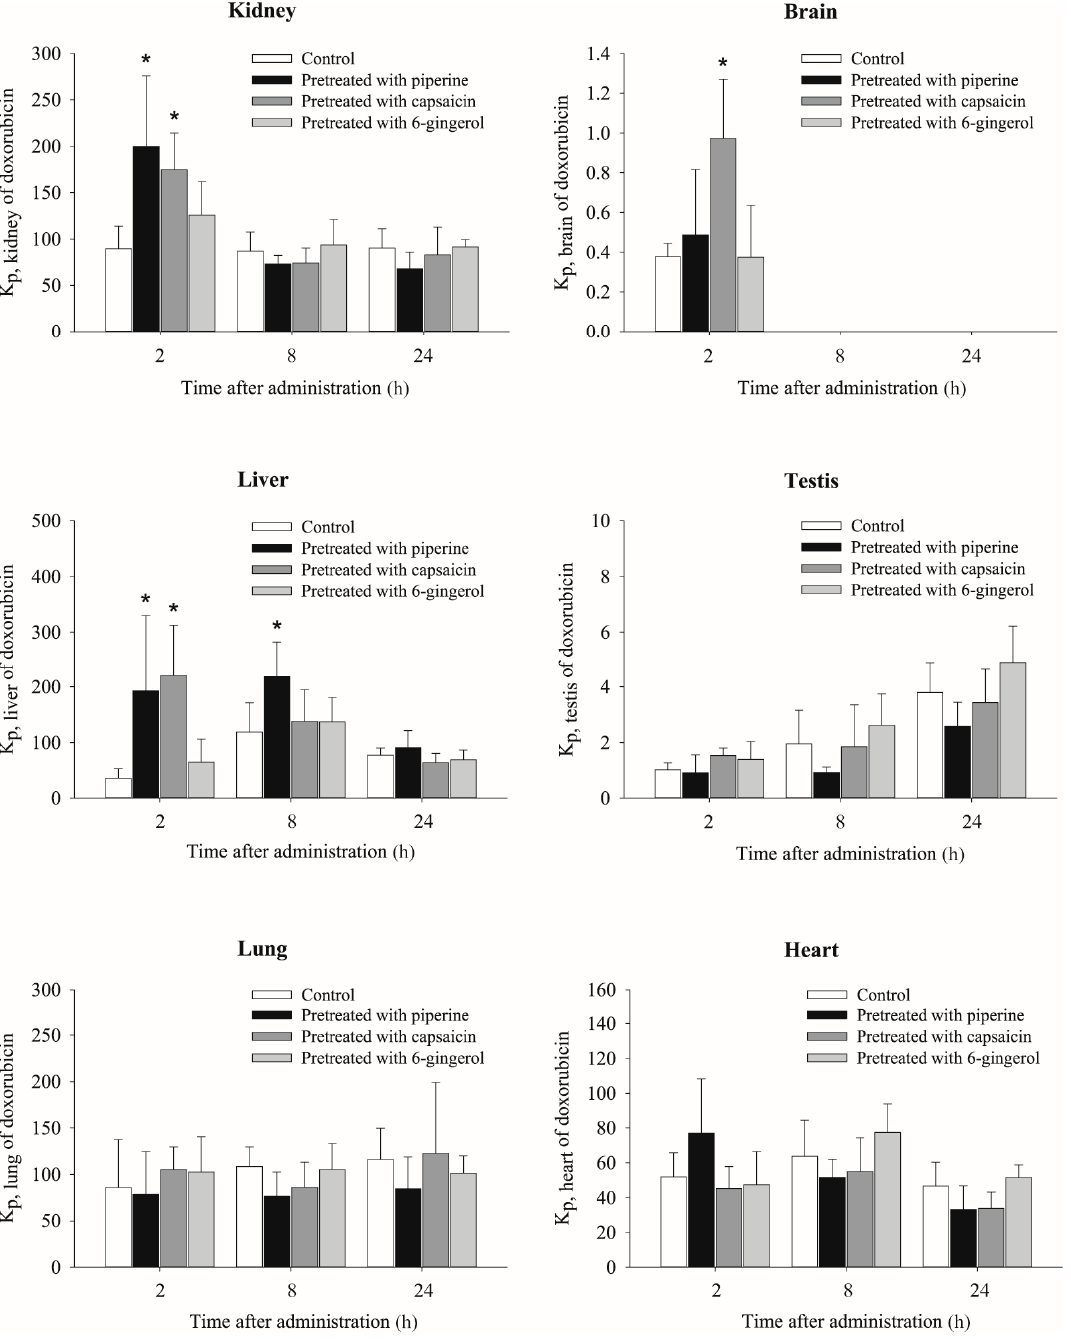
Figure 4. Tissue to plasma partition coefficients (K p ) of doxorubicin 2, 8 and 24 h after intravenous injection of doxorubicin at 1 mg/kg in mice pretreated with vehicle (control), piperine, capsaicin, or [6]-gingerol ( n = 6, mean ± SD). * p < 0.05 vs. control.